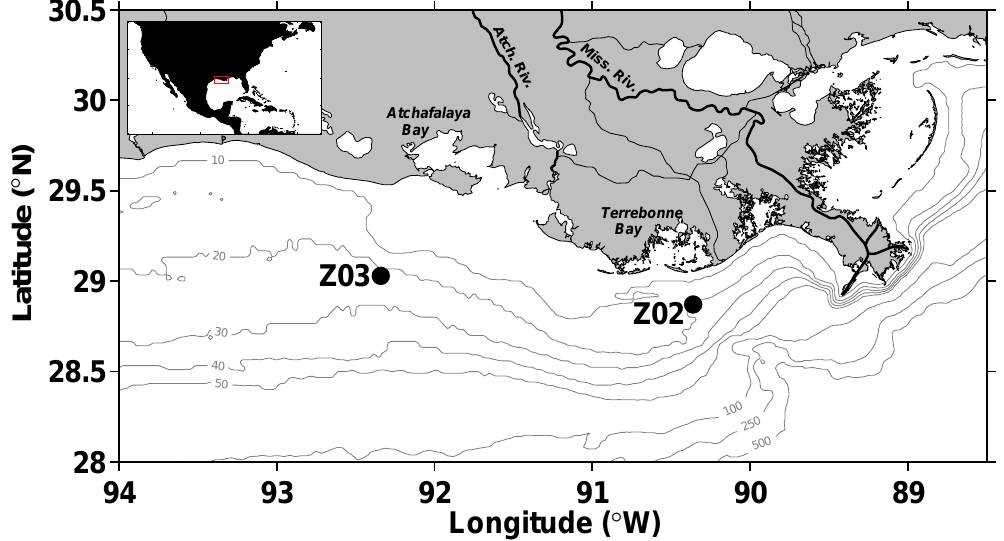
Figure 1. Map of the Louisiana Shelf showing the location of sample collection sites Z02 and Z03.